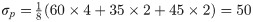
Operating with taxonomic trees.(A) Example of the recursive function which ‘folds the tree’ to prepare the taxonomic trees for further operations, with the parameter mintaxa set to 10 (explicitly for this example), and the minimum rank of interest minrank set to ‘genus.’ Initially, their trees show the direct taxonomic classification results. Then, recursively, the leaves of the tree are accumulated in the parent node if their number of assigned reads is under mintaxa (shown in red and bold counts) or if their corresponding taxonomic rank is below minrank. In this ‘folding’ the parent score is updated with a weighted average of its own score and the ones of the descendants that are being accumulated. E.g., after the 1st step, the G1 taxon at the sample is updated with np = 2 + 4 + 2 = 8 counts and score of σp=18(60×4+35×2+45×2)=50. As the counts for G1 are still under mintaxa, in the 2nd step they are accumulated in F1 and its score updated to 110(50×8+100×2)=60. (B) Continuing with the example in (A), at genus level, there are two derived samples: the right one with the control removed from Sample1, the left one with the exclusive taxa of Sample2 (those taxa not present in the rest of samples, in this case, the control and Sample1).